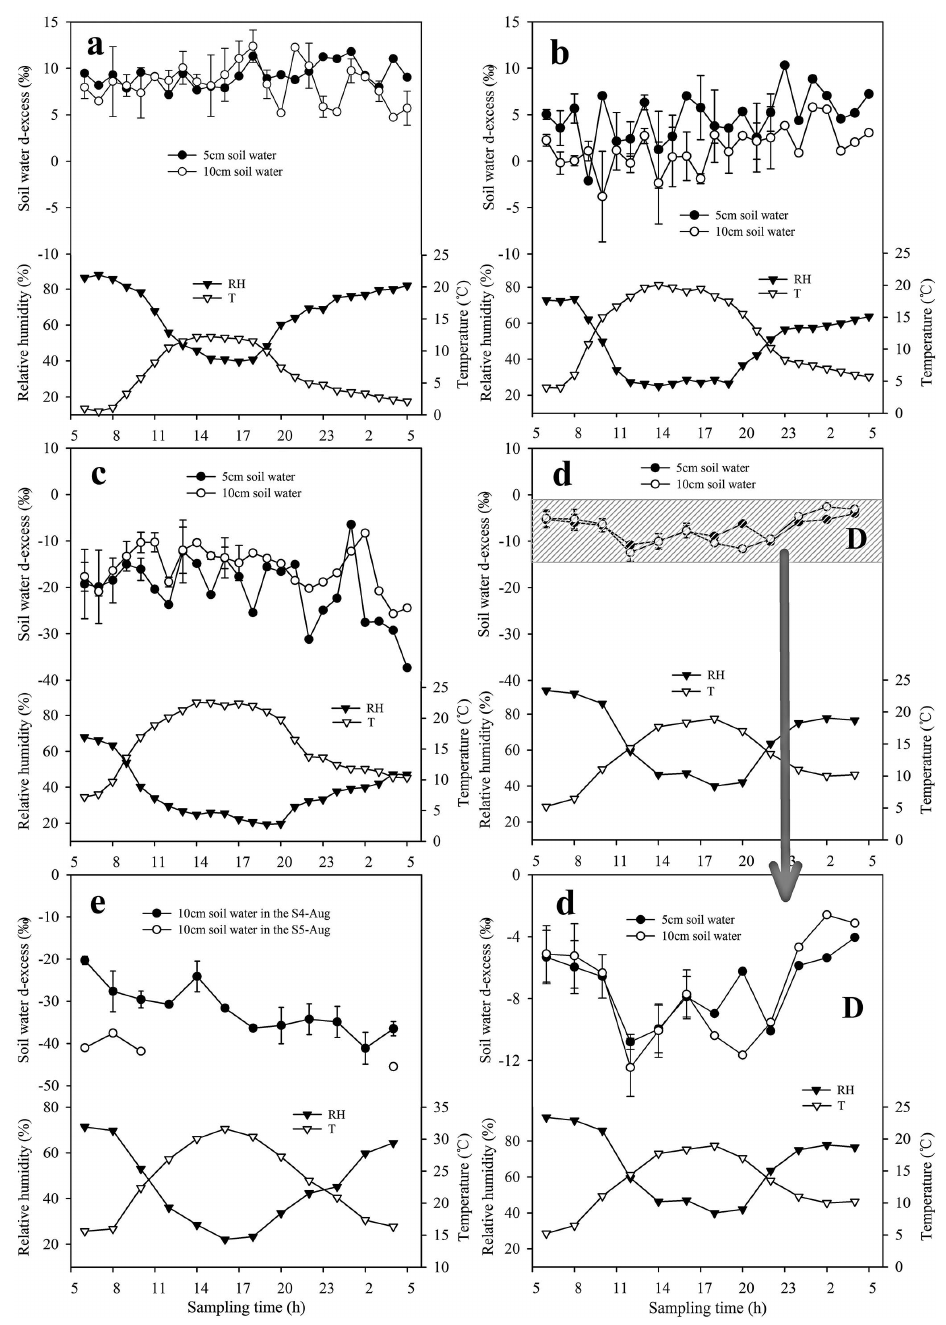
Figure 5. Spatial and temporal variations in soil water d-excess in the Heihe River basin. Note: panels (a) , (b) , (c) , and (d) refer to the same locations as in Fig. 2, and panel (e) refers to S4-Aug and S5-Aug in the lower